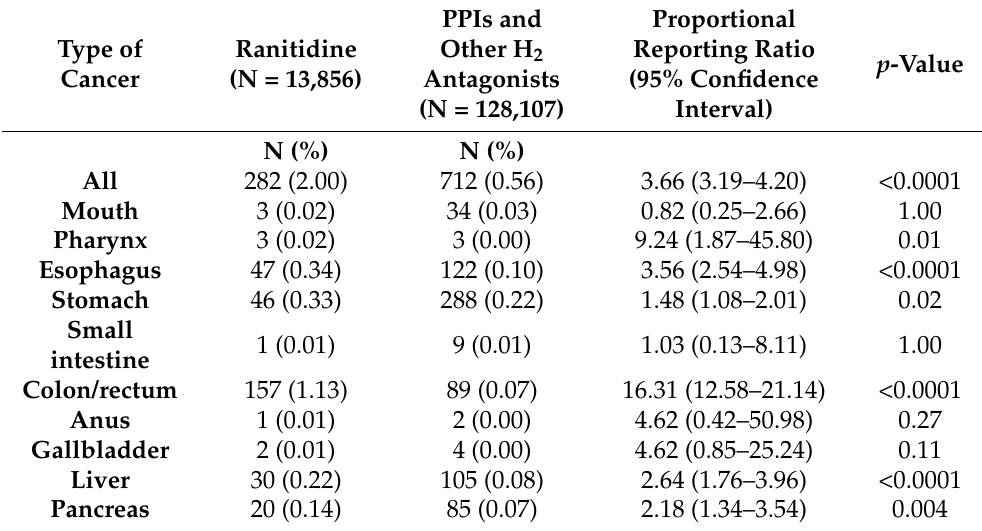
Table 2. Number and proportion of digestive system cancer-related adverse event reports for raniti- dine and PPIs and H 2 antagonists and associated proportional reporting ratios and 95% confidence